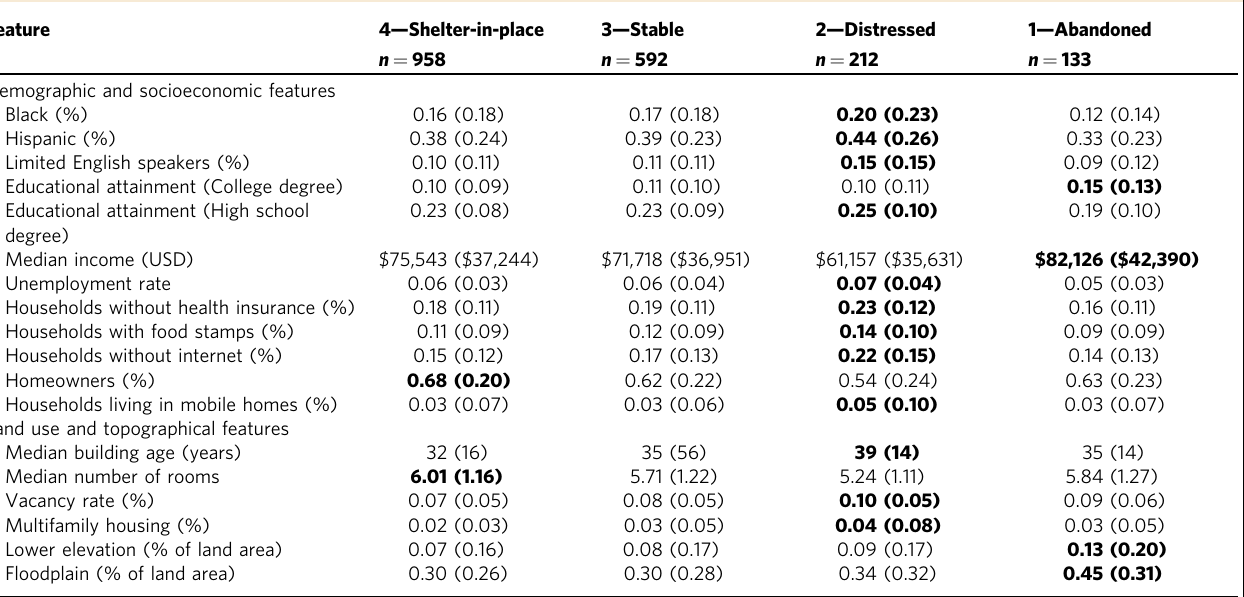
Table 2 Neighborhood cluster characteristics.